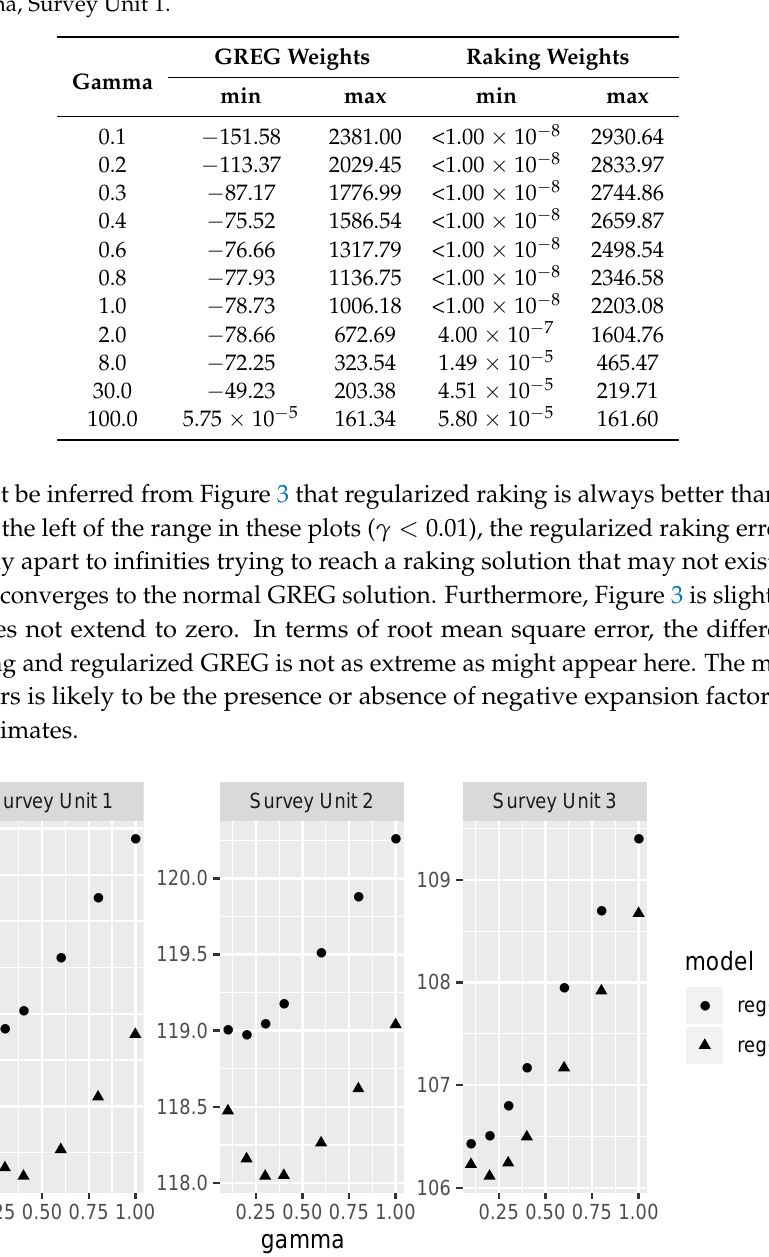
Table 3. Minimum and maximum expansion factors for the ridge GREG models and regularized raking. South Carolina, Survey Unit 1.